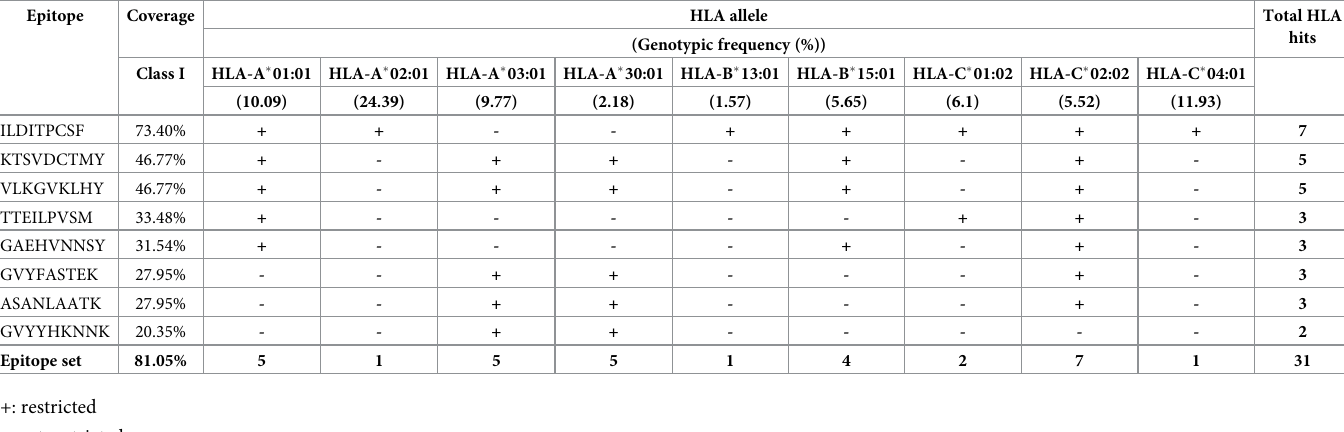
Table 5. Coverage of individual epitope (MHC class I) in the world. Epitope Coverage